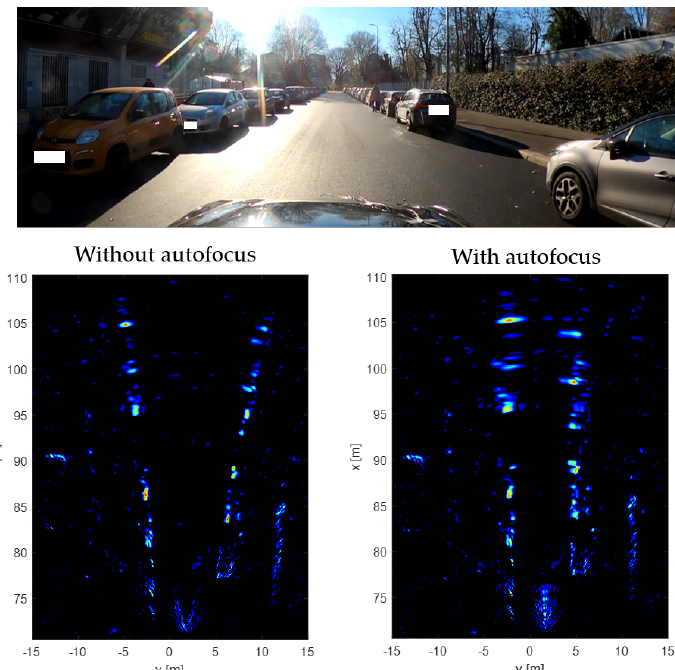
Figure 7. The impact of a motion compensation (autofocus) routine: ( top) camera image of a straight road with parked cars; ( bottom left ) SAR image without autofocus ( bottom right ) SAR image with autofocus. Without autofocus, residual trajectory estimation errors from navigation data severely degrade the imaging quality in terms of resolution and geometric